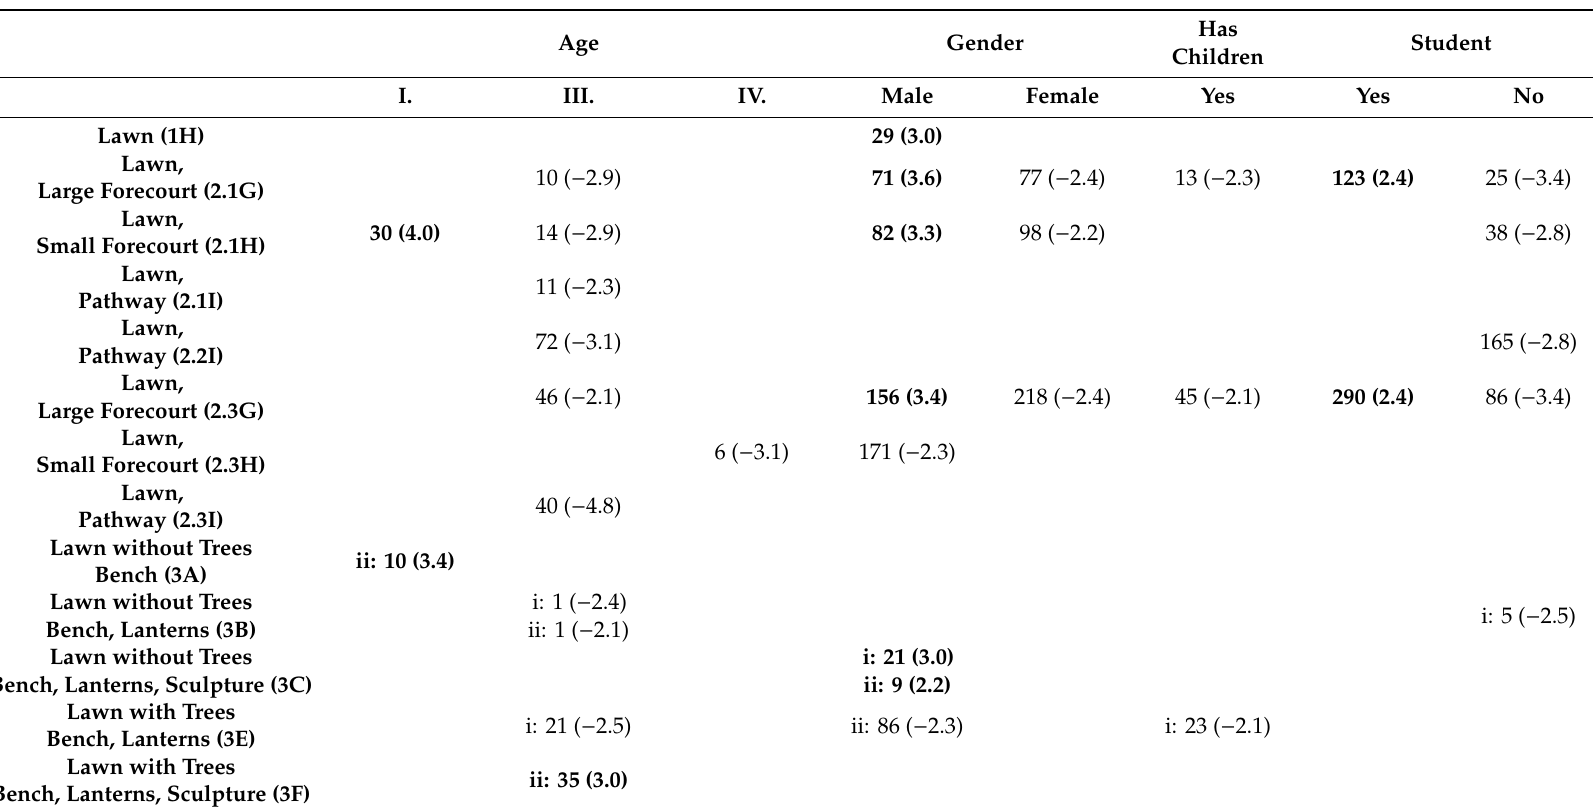
Table A1. Table of all the presented lawn areas that were significant with respect to age, gender, people with children, students, and non-students. The table presents the number of choices for a certain green space by the respective sociodemographic group (standardized residuals in brackets). Whereas a positive residual indicates that the scenario was appreciated by the relevant demographic group (bold type), a negative residual indicates that the scenario was disliked (normal typeface). Question 3 was divided into four sub-questions; each picture was presented twice as two separate questions: the results of (i) the first sub-question are shown in the upper line; results of (ii) the second sub-question in the lower